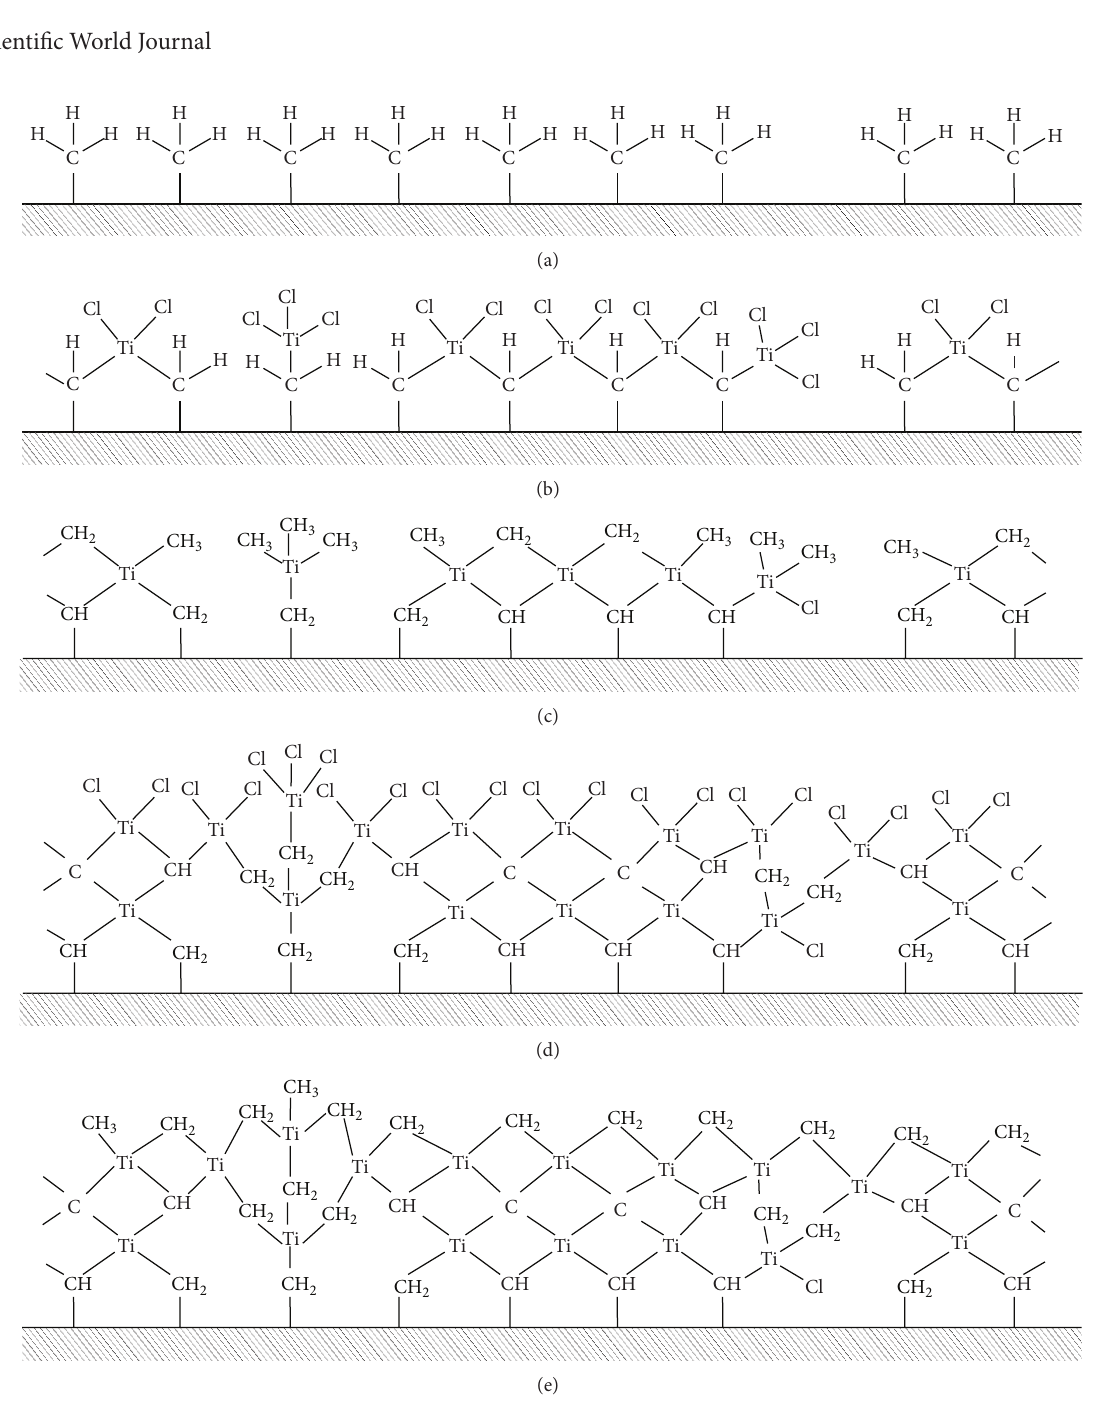
Figure 7: Diagram of the samples after process of atomic layer deposition with the cyclic supply of titanium tetrachloride and methane. (a) Initial surface of dispersed iron particles with methyl functional groups after exposure CH 4 ; (b) exposure of titanium tetrachloride giving titanium-chloride groups; (c) exposure of methane giving titanium-carbon groups; (d) and (e) repeated sequential exposures of titanium tetrachloride and methane, respectively (reactions